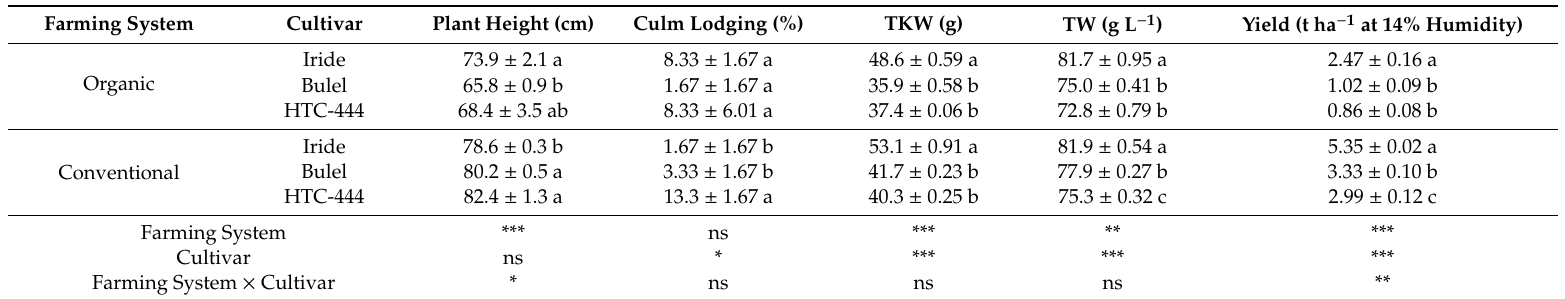
Table 2. Plant height and percentage of lodging at the heading stage, thousand kernel weight (TKW), test weight (TW), and grain yield (mean ± SE; n = 3) in durum wheat (cv. Iride) and Tritordeum (cv. HTC-444 and Bulel) cultivated under organic and conventional agricultural systems. Letters indicate statistically significant di ff erences among cultivars within the same farming system (Newman–Keuls test, p ≤